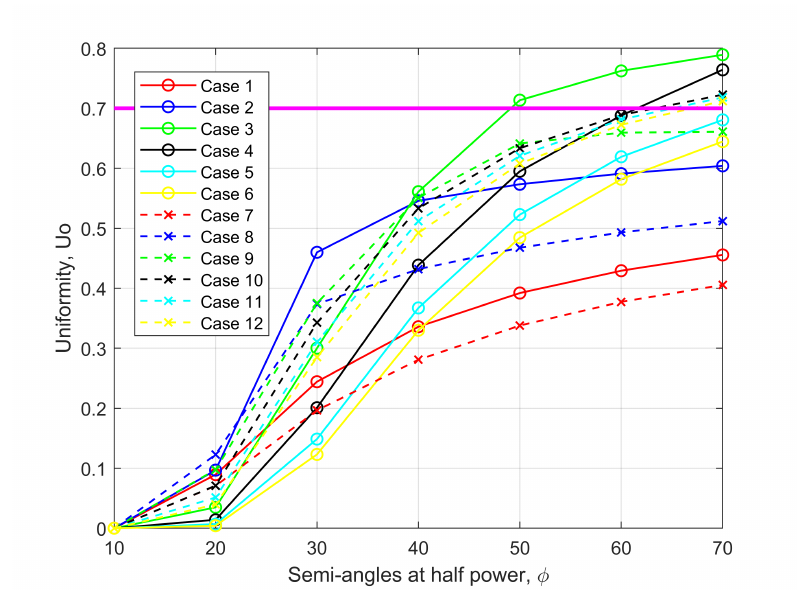
Figure 5. Uniformity of illuminance for cases I to XII at varying semi-angles at half power (SAAHP).